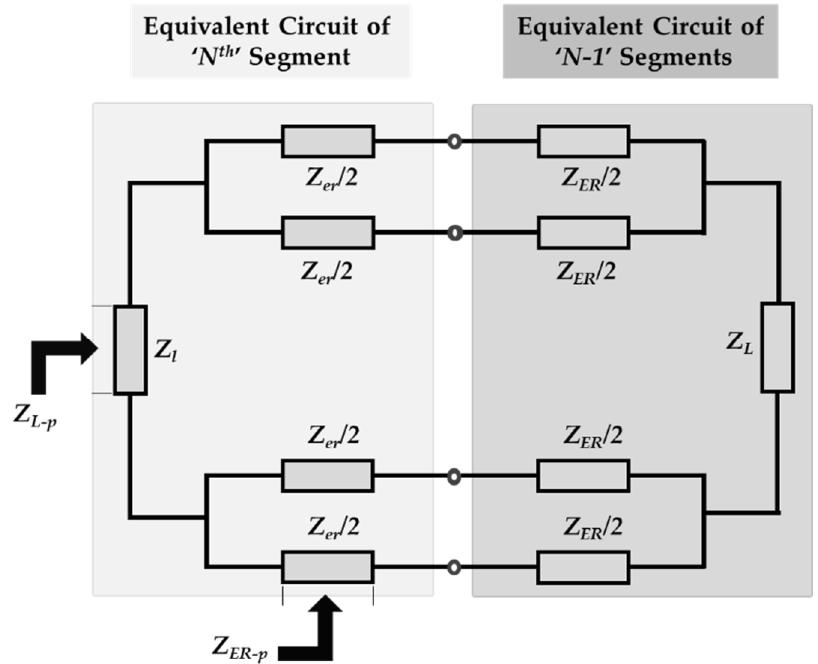
Figure 6. Equivalent circuit model of N segments birdcage RF coil by converting each segment into a two-port network.